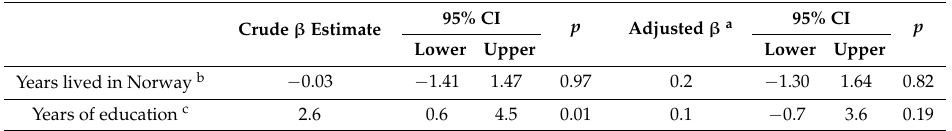
Table 3. Multiple linear regression showing the relationship between daily sodium excretion (mmol/24 h) and demographic factors; univariate (crude) and adjusted estimates are shown. Crude β